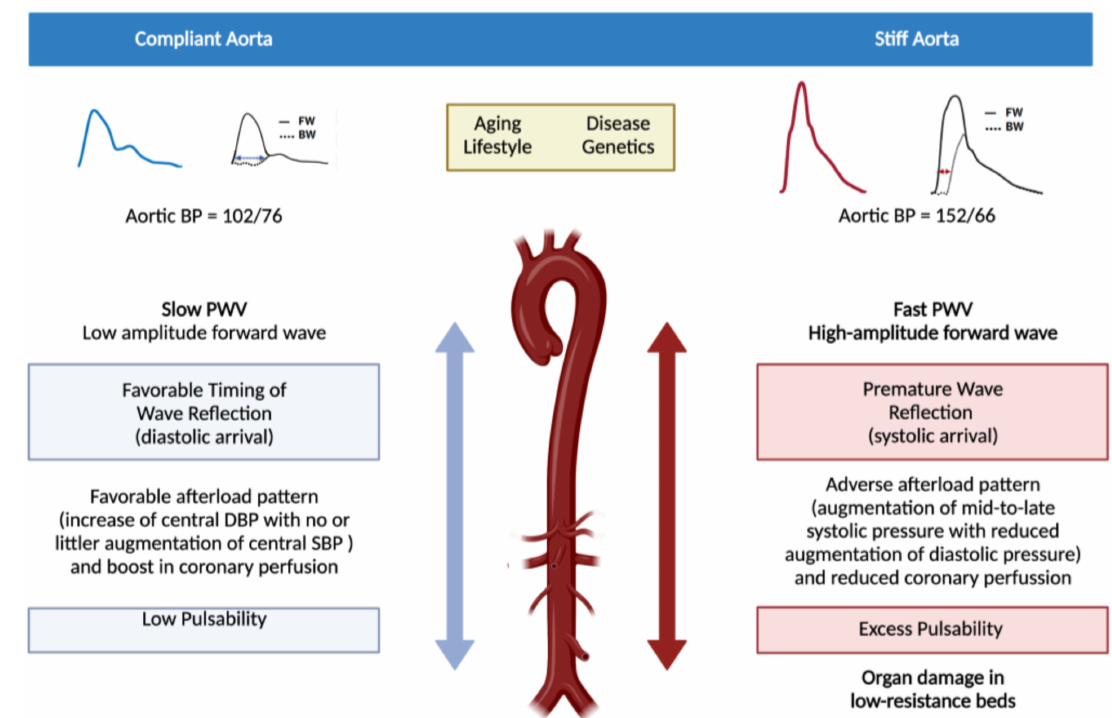
Figure 1. Impact of arterial stiffness on both the macro- and microvasculature. The figure compares a compliant aorta with a stiff aorta. In the left side a compliant (elastic) aorta is represented while the right represents a stiff aorta (vascular aging). Pulse waveform with their respective components of forward wave (FW, left ventricle to peripheral) and backward or reflected wave (BW, peripheral circulation to left ventricle) in both situations are shown. When the aorta is compliant, both components of the pulse wave (forward and backward) are slow and the backward component reaches the left ventricle in diastole with no increase in the physiological aortic pulse pressure and favoring myocardial perfusion (which mainly occurs in diastole). Under these conditions, blood flow reaches the microcirculation of the organs with low resistance and high flow with low pulsability and energy (left side of the figure). When the aorta stiffens, pulse wave velocity increases in both of its components, the forward component increasing the systolic blood pressure and the afterload of the left ventricle (first step towards its hypertrophy and failure) whereas the backward component reaches the left ventricle in the mid-to-late systole, compromising myocardial perfusion. In addition, blood flow increases its pulsability and energy when arriving at the low resistance high flow target organs, thus promoting their damage (right side of the